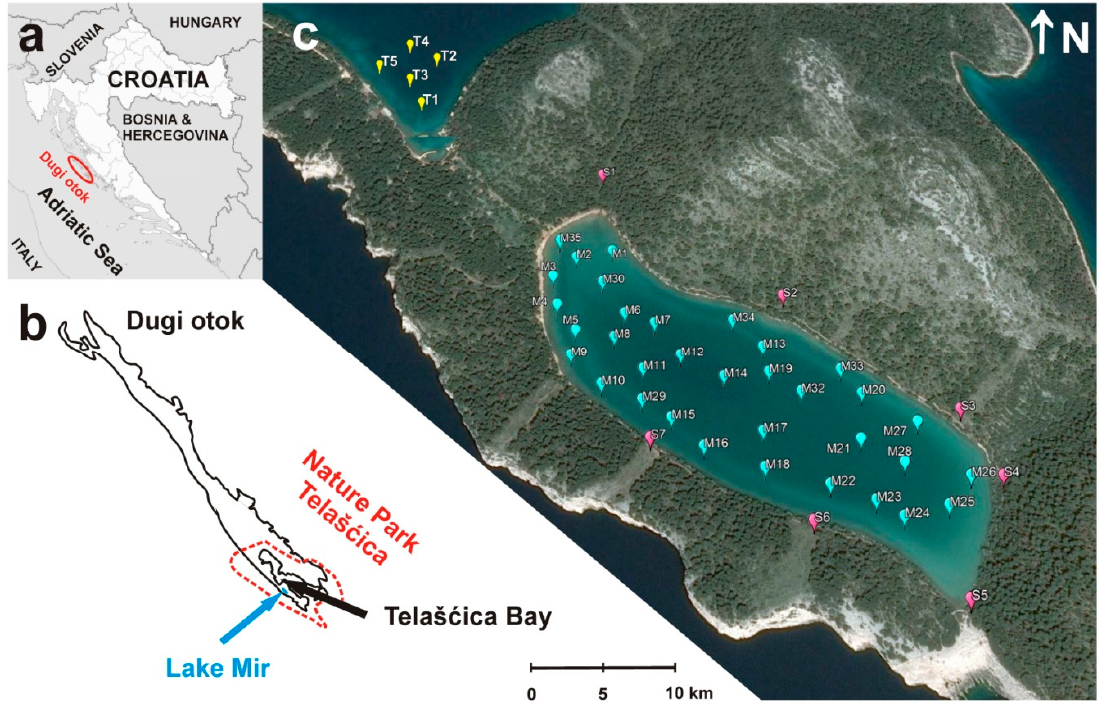
Figure 1. ( a ) Location of the Dugi otok Island; ( b ) location of the Lake Mir and the Telaš ć ica Bay on the Dugi otok Island; ( c ) map of sampling locations at the Lake Mir and the Telaš ć ica Bay (Google Earth, 2018).